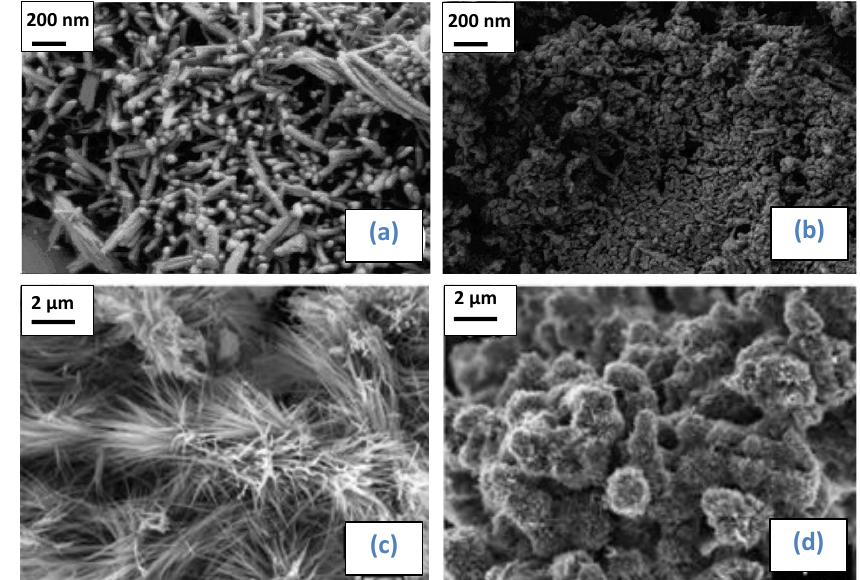
Figure 13. SEM images of alumina particles prepared from aluminium isopropoxide (AIP) and acetic acid in scCO 2 at 80 °C: ( a ) AIP/scCO 2 = 0.3 mmol/mL, AIP/acetic acid = 1:10, 414 bar; ( b ) AIP/scCO 2 = 0.5 mmol/mL, AIP/acetic acid = 1:10, 414 bar; (Adapted with permission from [11]. Copyright American Chemical Society, 2009.) and SEM images of titania particles prepared from titanium butoxide (TBO) or titanium isopropoxide (TIP) and acetic acid in scCO 2 ; ( c ) 1.1 mol/L TBO, 6.1 mol/L acetic acid, 40 °C, 172 bar; ( d ) 1.5 mol/L TIP, 6.1 mol/L acetic acid, 60 °C, 414 bar. The samples were measured without grinding or gold coating. (Adapted with permission from [97]. Copyright